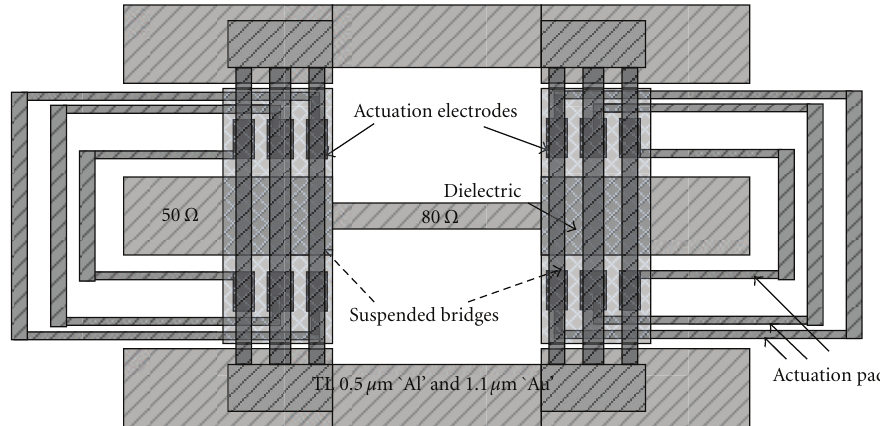
Figure 3: The top view of the proposed low pass filter with actuation mechanism.